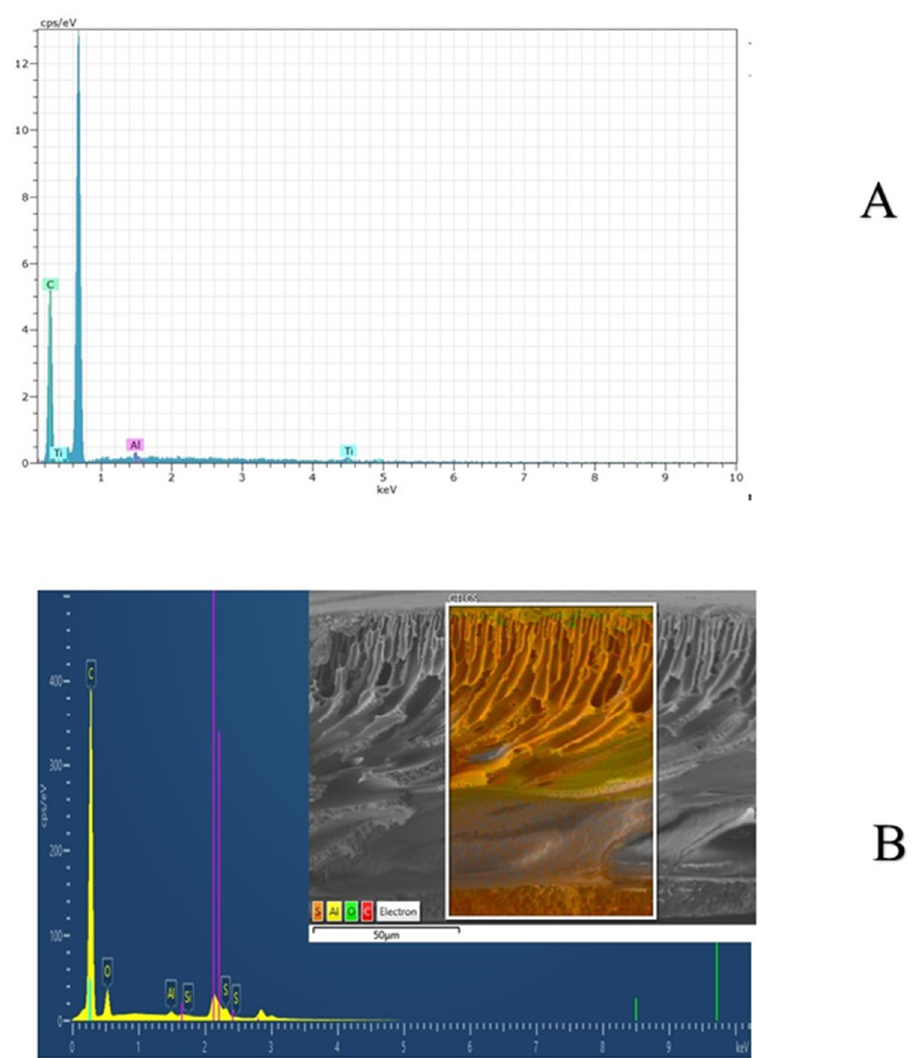
Figure 6. EDX analysis of ( A ) MXene and ( B ) 1.5%MXene-modi fi ed PPSU